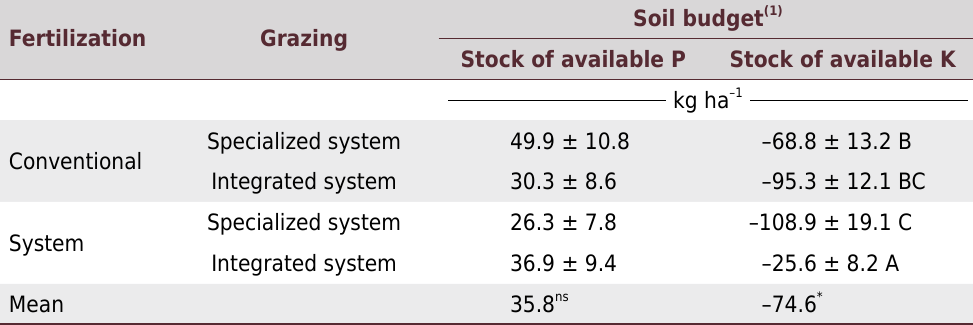
Table 4. Available P and K budgets in the 0.00-0.20 m soil layer as affected by fertilization strategy (conventional or system fertilization) and animal effect (specialized system or integrated system) in the ICLS